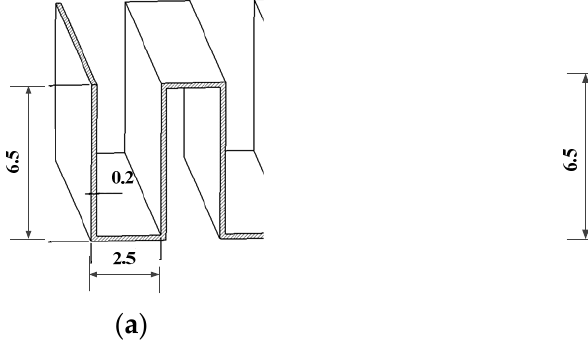
Figure 4. Structural shape of external fins. ( a ) B1, ( b ) B2. Table 3. Structural parameters of external fins.